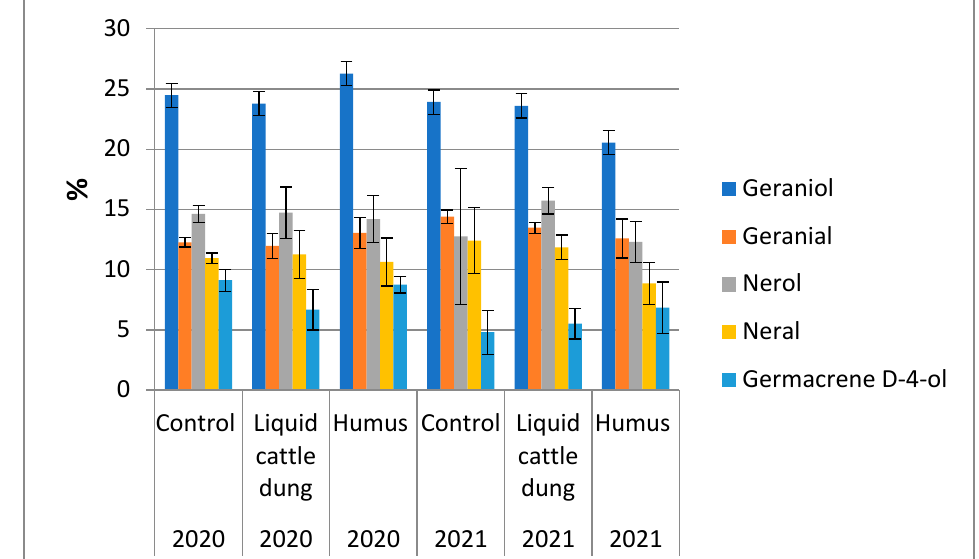
Figure 4. Variations in the percentage of some chemical compounds in essential oils of Thymus × citriodorus depending on the fertilization treatment in the first and second experimental years. A summary of findings of this research study is presented in Figure 5. A positive correlation (very strong, strong and weak) was observed between the year and area covered by plant (0.8), the upper leaf epidermis density of stomata (0.4), the upper leaf epidermis size of glandular trichomes (0.9), the lower leaf epidermis density of stomata (0.8), the lower leaf epidermis density of glandular trichomes (0.8), the lower leaf epidermis size of glandular trichomes (0.20) and the percentage of geranial (0.6), as well as between fertilization and the upper leaf epidermis density of stomata (0.70), the upper leaf epidermis density of glandular trichomes (0.9), the upper leaf epidermis size of glandular trichomes (0.2), the lower leaf epidermis size of glandular trichomes (0.2), the amount of essential oil (0.1) and the percentage of germacrene D-4-ol (0.9). For other parameters, negative correlations were